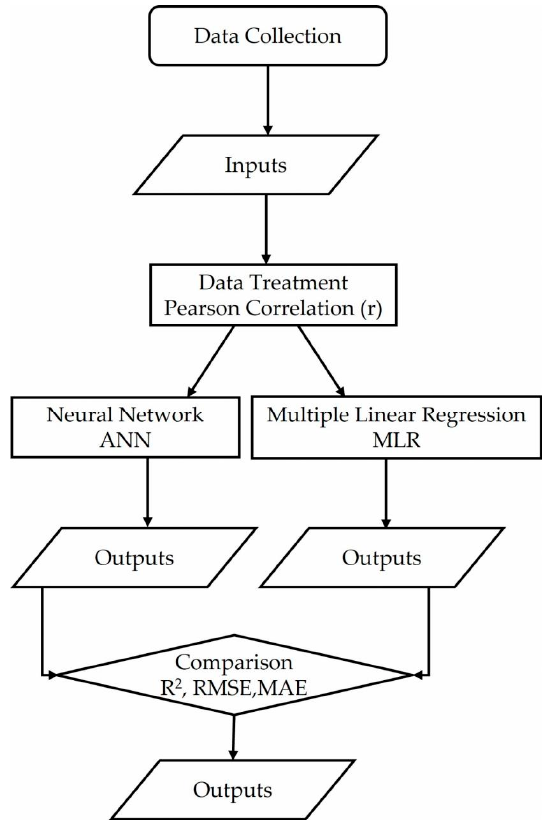
Figure 2. General process flow chart.